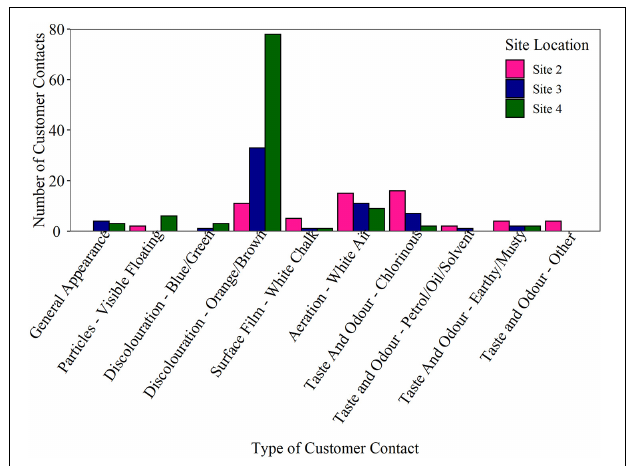
FIGURE 7 | Customer contact numbers for the district metered areas (DMAs) supplied by Site 2, Site 3, and Site 4 trunk mains for the last 6 years. Over this time period, 59 customer contacts were received at Site 2, 90 at Site 3 and 130 customer contacts at Site 4. Raw data is plotted as the population served by each trunk main is similar (4,342 persons at Site 2, 5,021 persons at Site 3, and 6,226 persons at Site